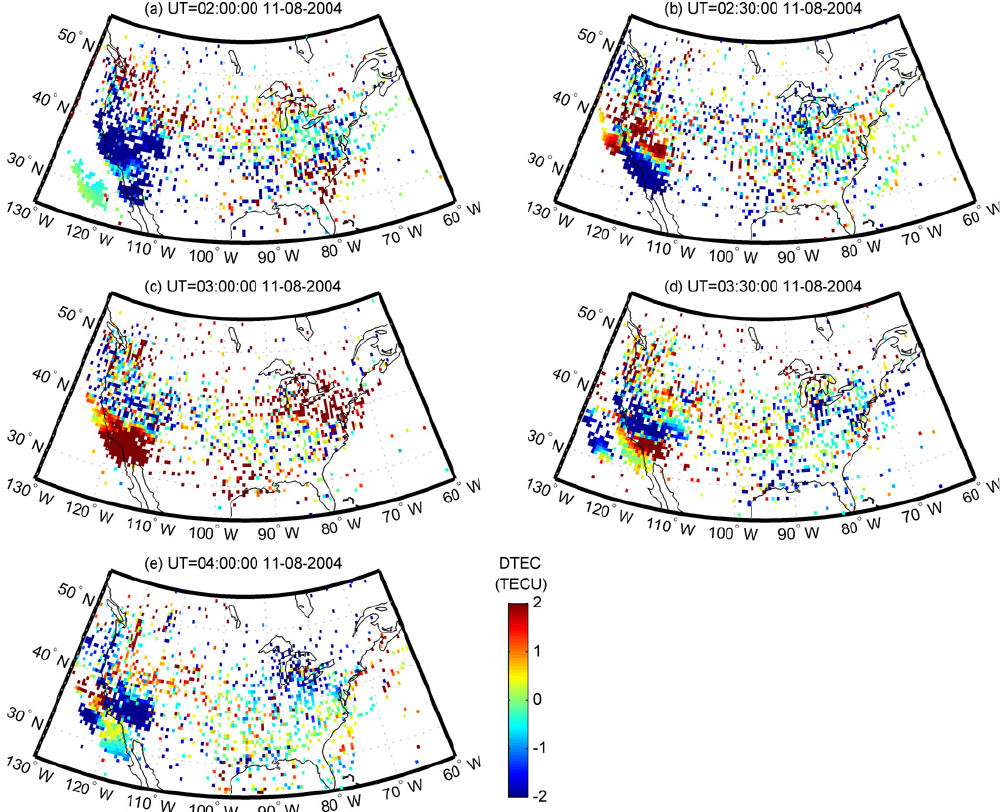
Fig. 4. Time sequence of two-dimensional maps of TEC perturbations over North America during the period of 02:00 ∼ 04:00UT on 8 November